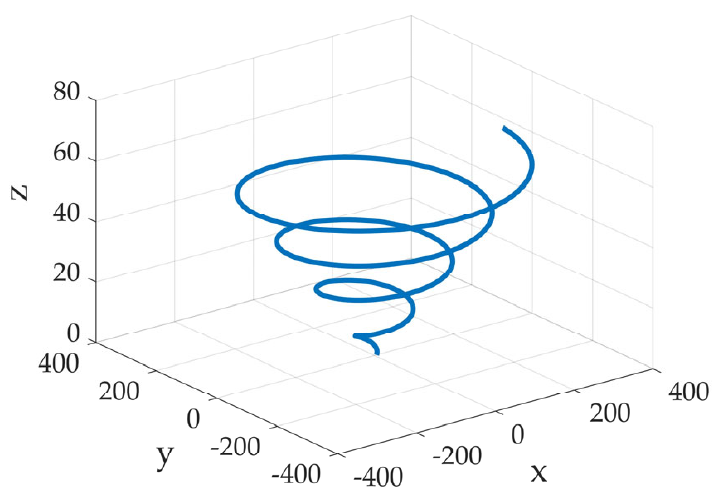
Figure 2. Schematic diagram of spiral motion.